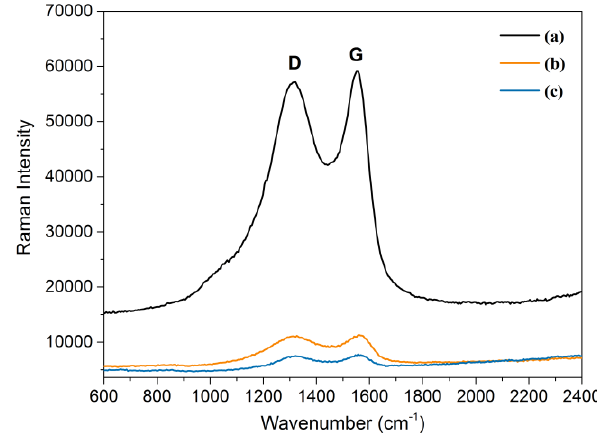
Figure 3. Raman spectra of PAC ( a ), Fe 3 O 4 -PAC ( b ), and Cu-Fe 3 O 4 -PAC ( c ).